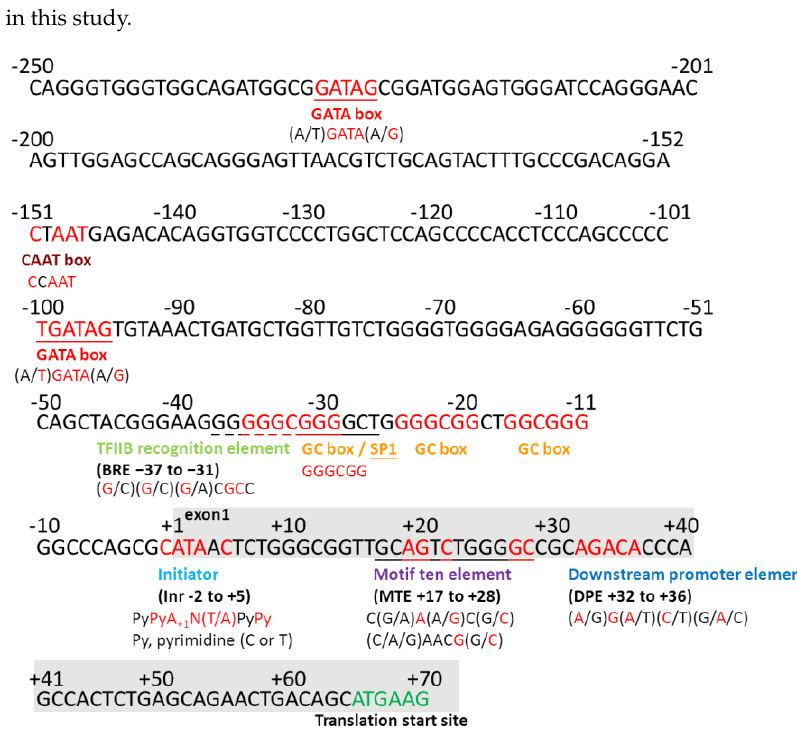
Figure 2. Prediction and analysis of the human MFAP4 promoter. The presented region is from position +70 to −250. The corresponding elements and consensus sequences are shown at the bottom of the main sequence. Py: pyrimidine (C or T), N: any base.